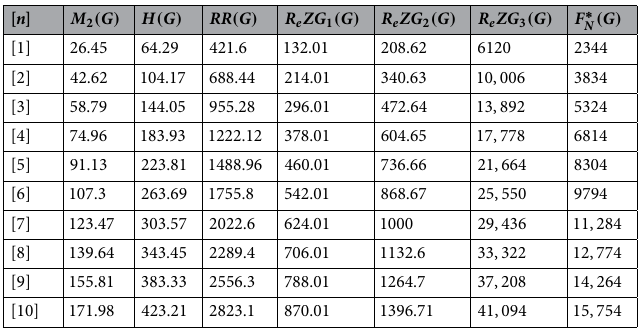
Table 4. Comparison of M 2 ( G ) , H ( G ) , RR ( G ) , R e ZG 1 ( G ) , R e ZG 2 ( G ) , R e ZG 3 ( G ) and F ∗ N ( G ) .